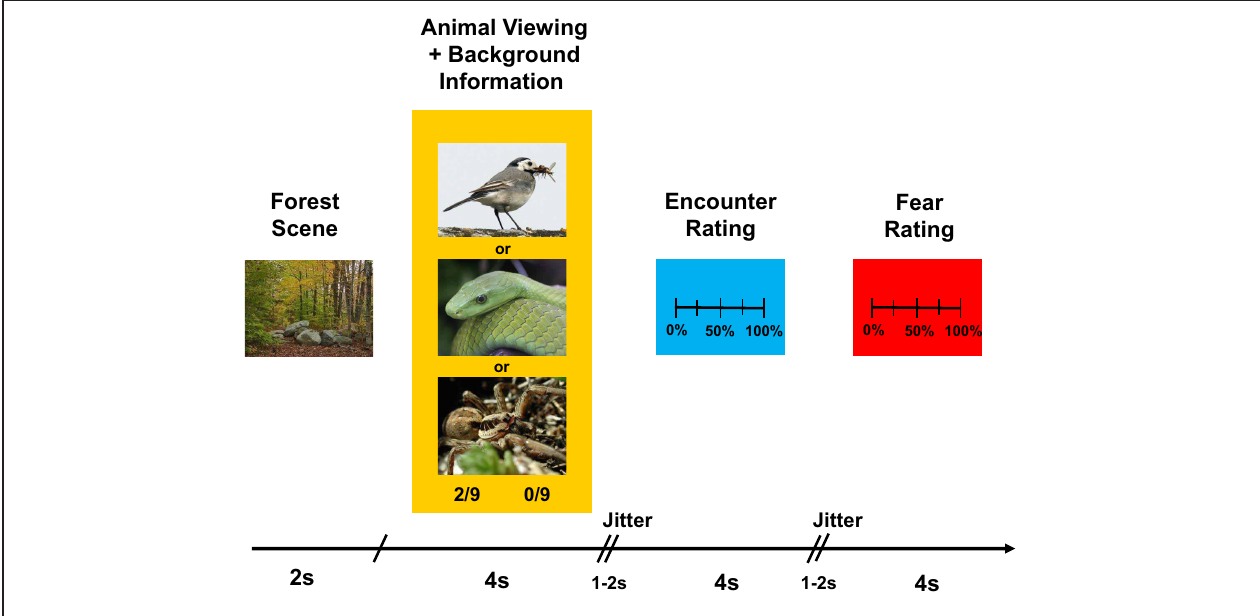
FIGURE 1 | Timeline of an experimental trial. See text for more details.